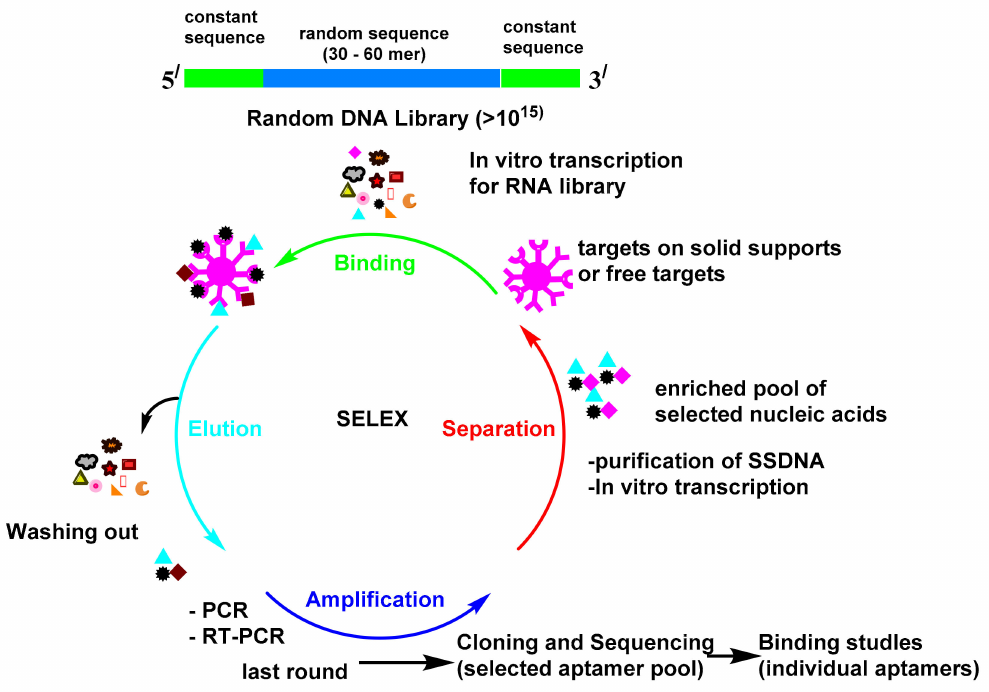
Scheme 1. Systematic evolution of ligands by exponential enrichment